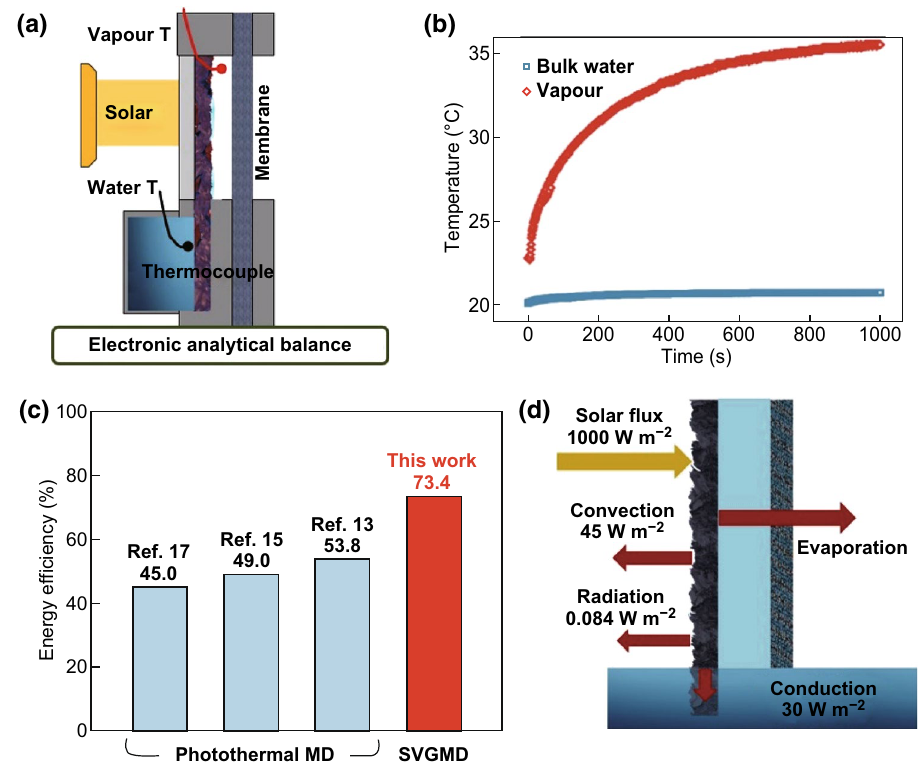
Fig. 3 Record-high solar-water efficiency in SVGMD and its excellent performance in desalination of natural seawater and salty brine and puri- fication of mineral oil-contaminated water. a Schematic of SVGMD with the solar simulator. b The temperature of vapour in the gap and bulk water in the tank as a function of time at an illumination of 1 kW m −2 . c Comparison of energy efficiency between current work and previous studies [13, 15, 17]. d The energy balance and heat transfer in